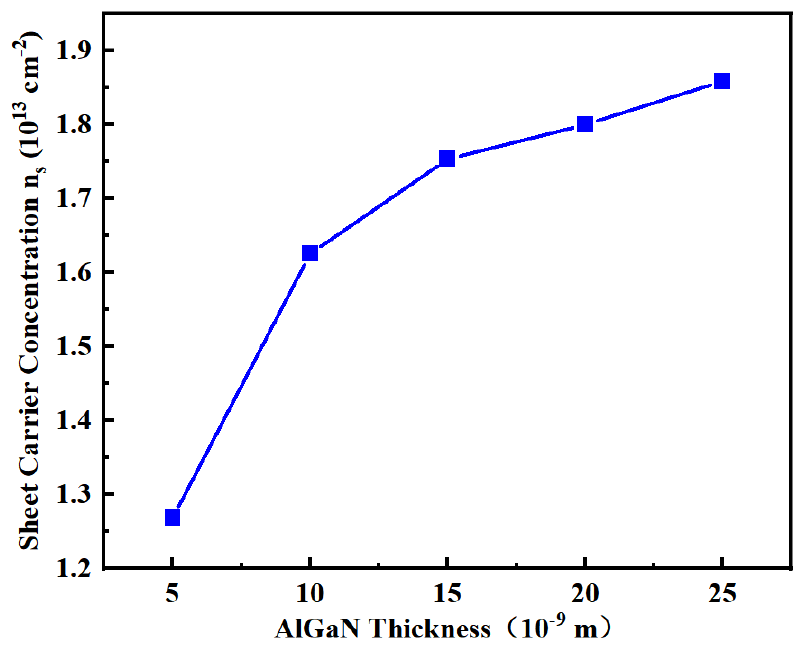
Figure 5. When Al% = 0.25, d In0.1Ga0.9N = 5 nm, and r = 0.5, the AlGaN barrier layer is fully strained, the 2DEG concentration at the AlGaN/InGaN interface n s is at a different d AlGaN .